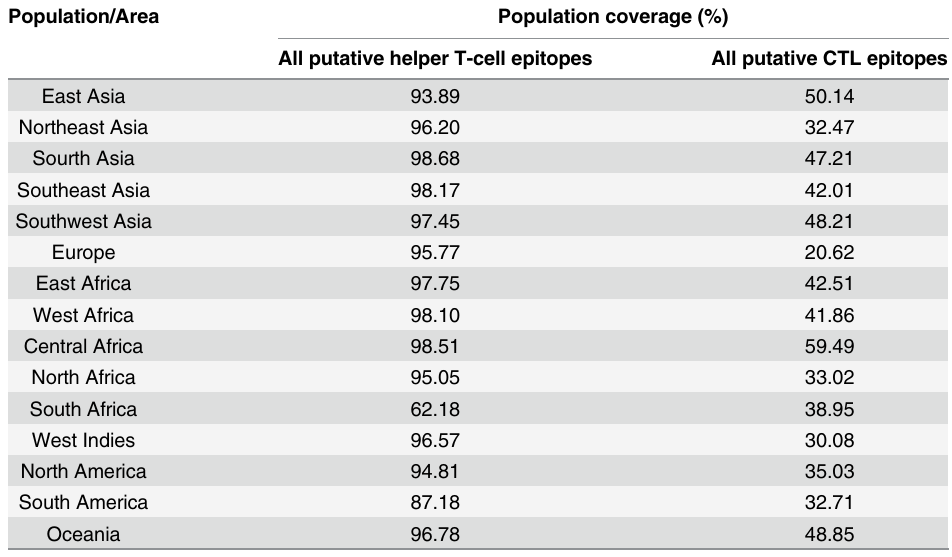
Table 6. Population coverage rate (%) for all putative helper T-cell epitopes and CTL epitopes of the N protein of MERS-CoV.